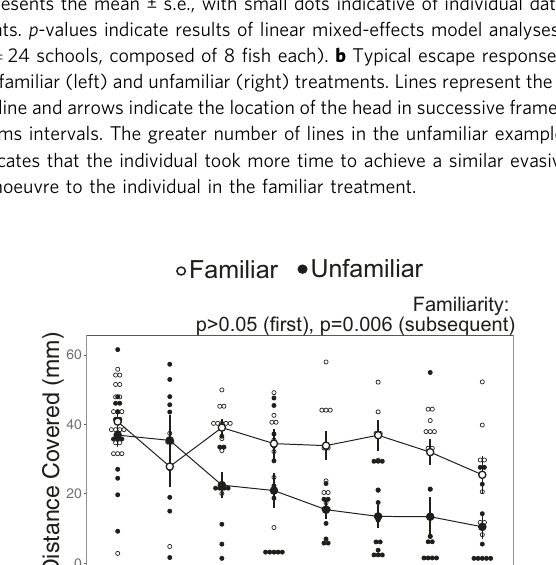
dination were measured during the 100 ms time period following the simulated predator attack. This short time frame following a predator attack is crucial for survival 30,31 . School cohesion was assessed using nearest neighbour distance (NND; distance to the closest neighbour) and school area (horizontal spread of the school), while school alignment (length of the mean circular vector, a measure of the variation in fi sh orientations) was used as a proxy for spatial coordination of individuals within the school 56 . These school characteristics were measured at set time points throughout the escape response (time = 0, ~20, and ~100 ms after stimulus onset), representative of before, during, and after the escape response on average in this species 54 (complete model output detailed in Supplementary Table S5).